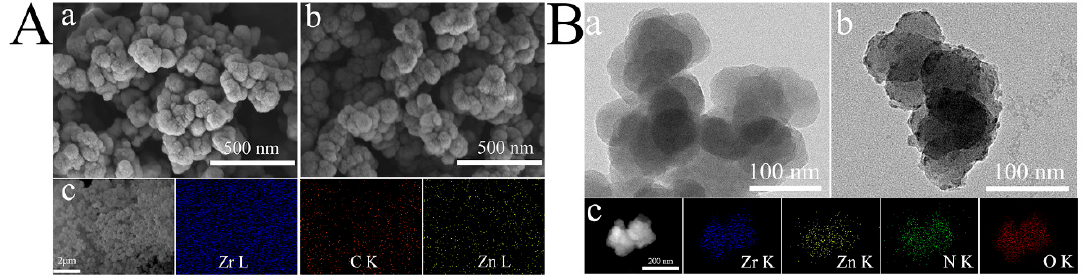
Figure 3. Scanning electron microscopy (SEM) ( A ) and transmission electron microscopy (TEM) ( B ) images of ( a ) UiO-66-NH 2 , ( b ) zeolitic imidazolate framework-8 (ZIF-8)-loaded UiO-66-NH 2 , and ( c ) energy-dispersive X-ray spectroscopy (EDS) mappings of the ZIF-8-loaded UiO-66-NH 2 . N 2 adsorption/desorption isotherms of UiO-66-NH 2 and ZIF-8-loaded UiO-66-NH 2 (1-ZIF-